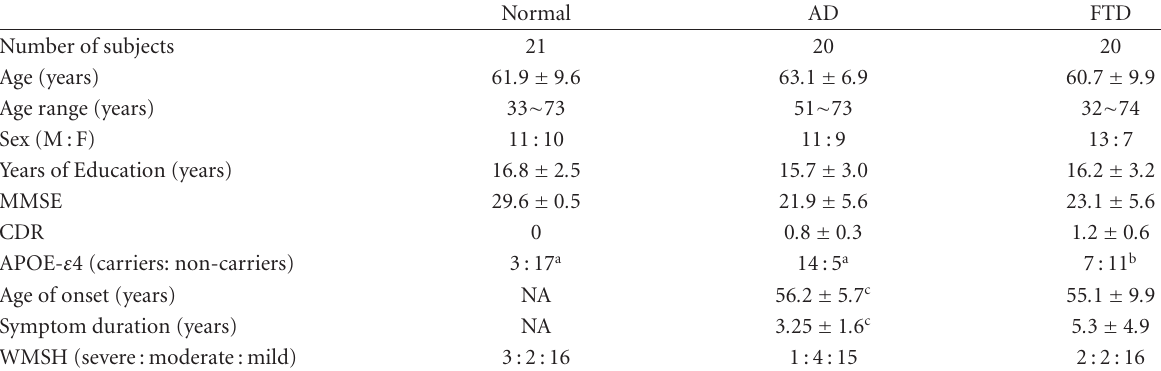
Table 1: Demographic and clinical data